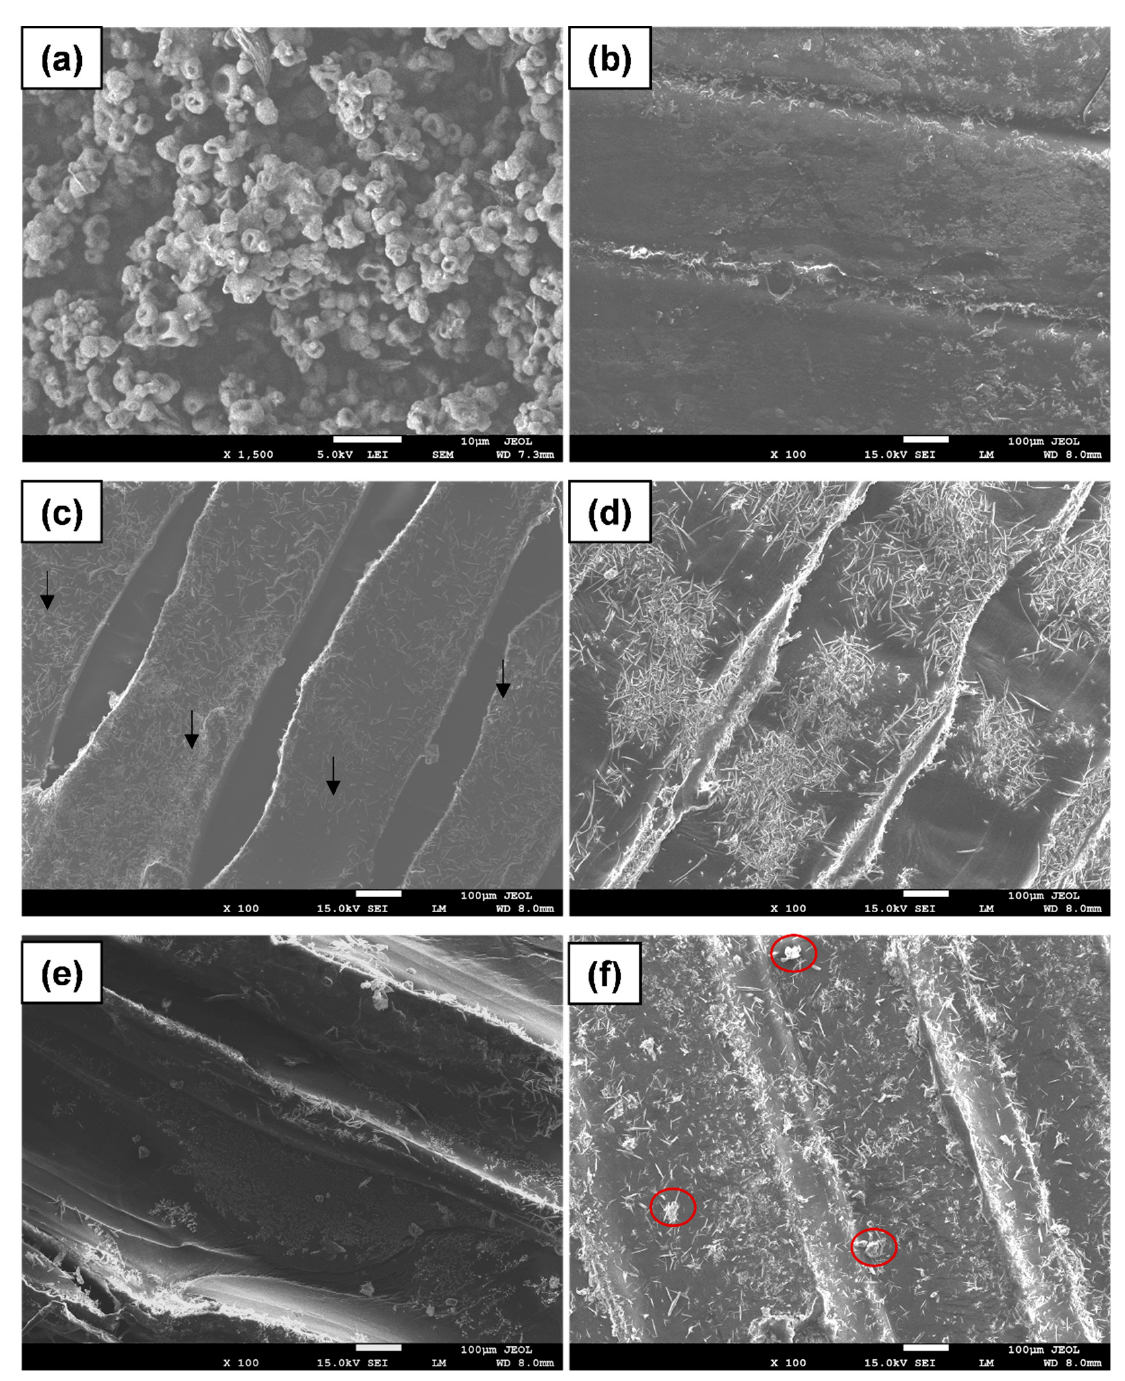
Figure 3. SEM micrograph of lignin ( a ), PBS ( b ) and PBS/lignin composites with 0.5 ( c ), 1.5 ( d ), 2.5 ( e ), and 3.5 ( f ) % of lignin. The arrows show well-dispersed lignin particles, while the red circles show agglomerated lignin particles.